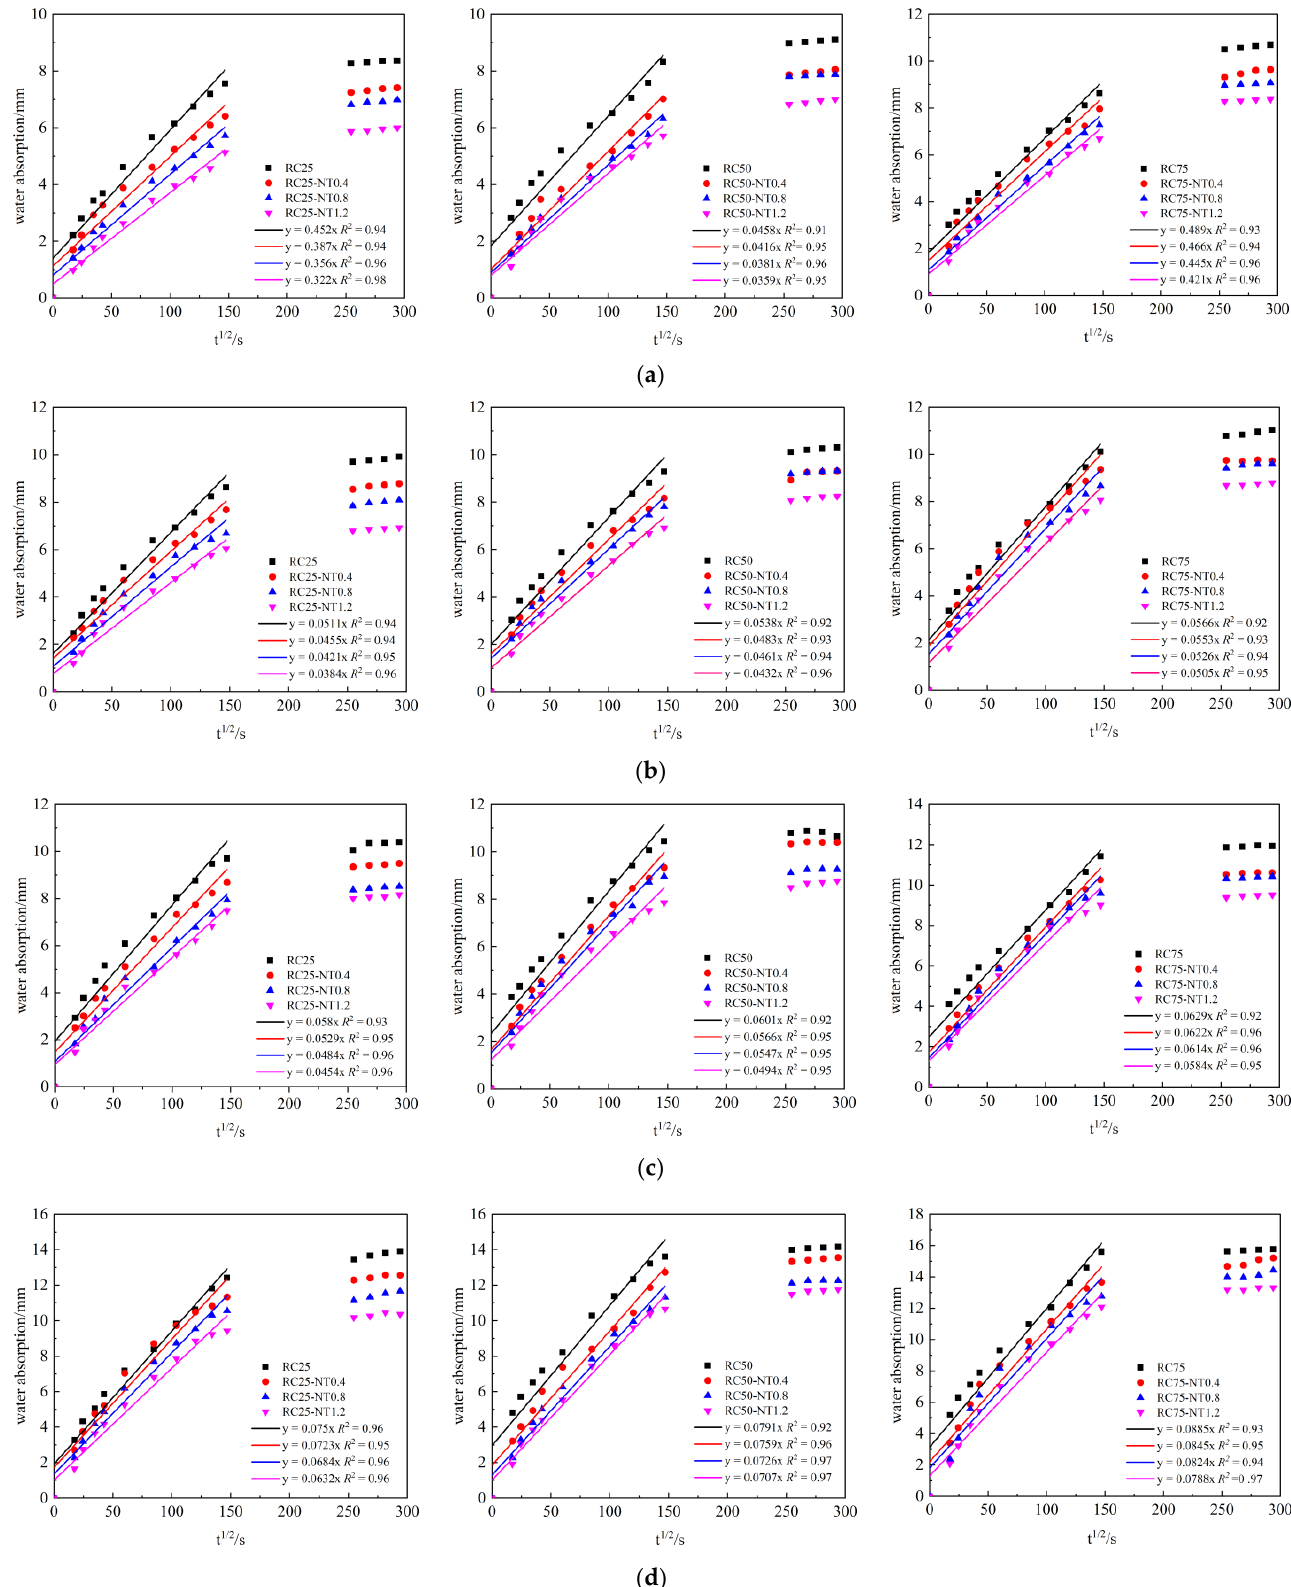
Figure 5. Cumulative water absorption and time – square-root relationship diagram. ( a ) n = 0; ( b ) n = 50; ( c ) n = 100; ( d ) n = 150.